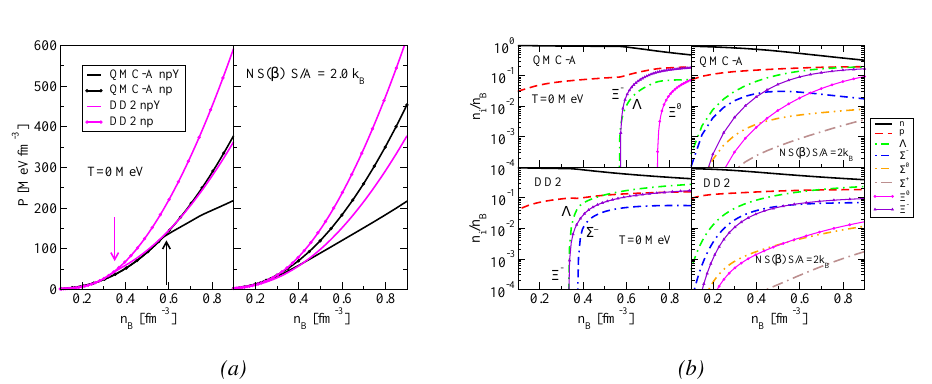
Figure 2: (a) Equations of state of the QMC and DD2 models at T = 0 MeV (left) and warm NS( β ) matter (right), for full baryon octet (solid) and for only nucleons (dashed). (b) Relative population of nucleons and hyperons in units of the total baryon number density at T = 0 MeV (left) and NS( β ) matter (right). Only populations higher than 0.01% in the region of 0.1 - 1 fm − 3 are shown (right). The figure is adapted from [2].